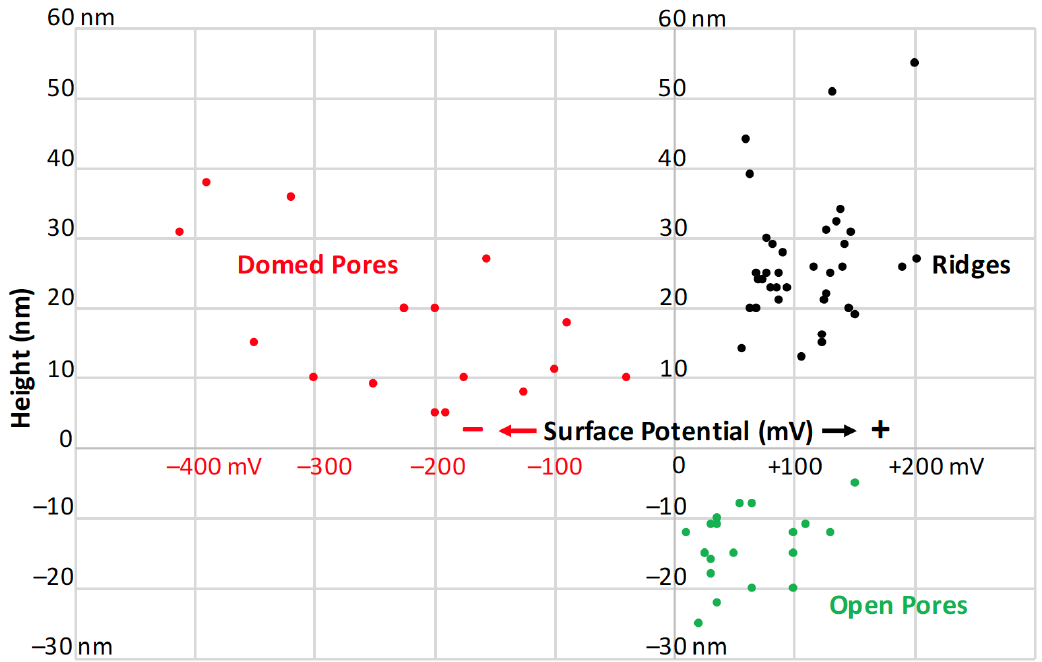
Figure 7. AFM surface potential readings from a 2 µm x 2 µm section of a Lymantria dispar trichoid sensillum related to height of domes, depth of open pores, and height of ridges. Note the mesh area of ridges in these images, incompletely crossing the surface of the sensillum. ( A ) Topography scan of the sensillum. Heights of domes and depths of pores are indicated on the figure. ( B ) Correspond- ing surface potential scan of this same section. Note the negative surface potentials of domes and positive surface potentials of pores. The ridges stand out as having more positive surface potentials than the flat planar inter-ridge regions.